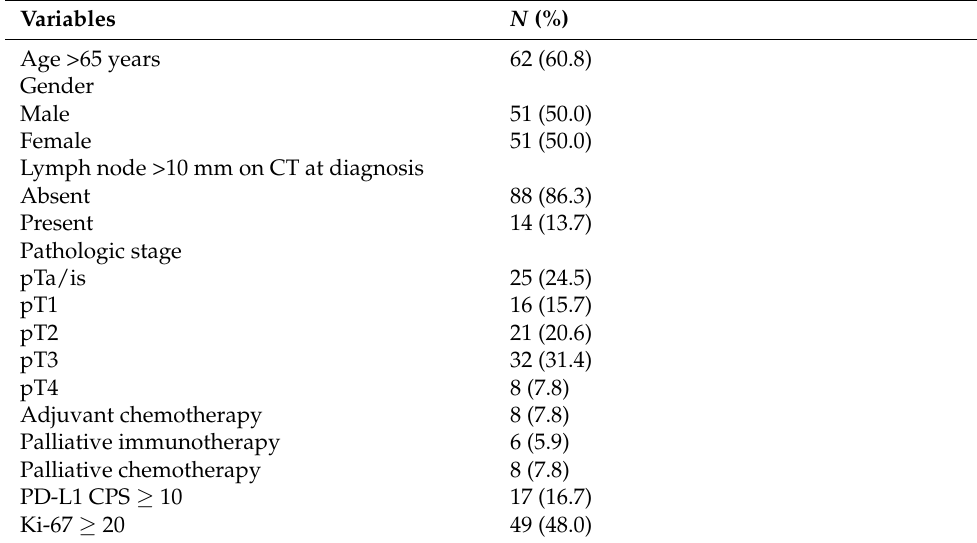
Table 1. Demographic characteristics of the 102 patients with